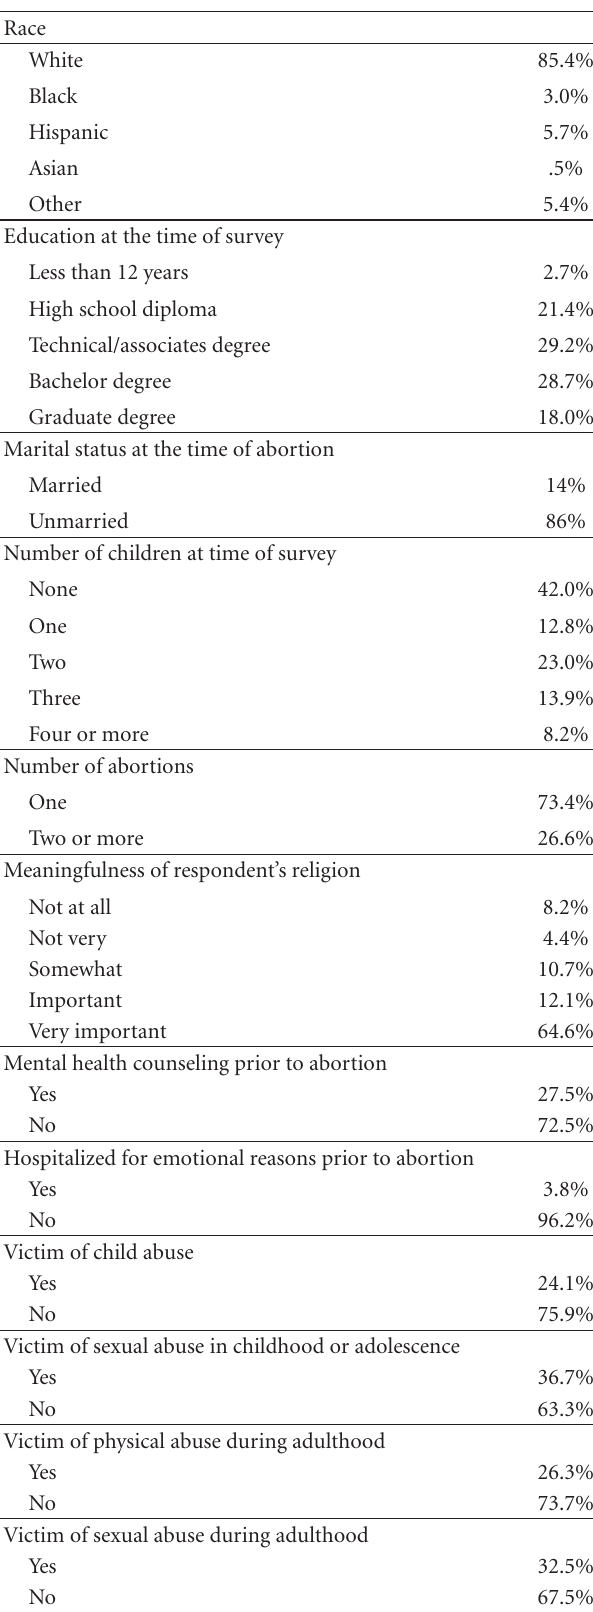
Table 1: Frequencies of demographic and control variable cate- gories for full